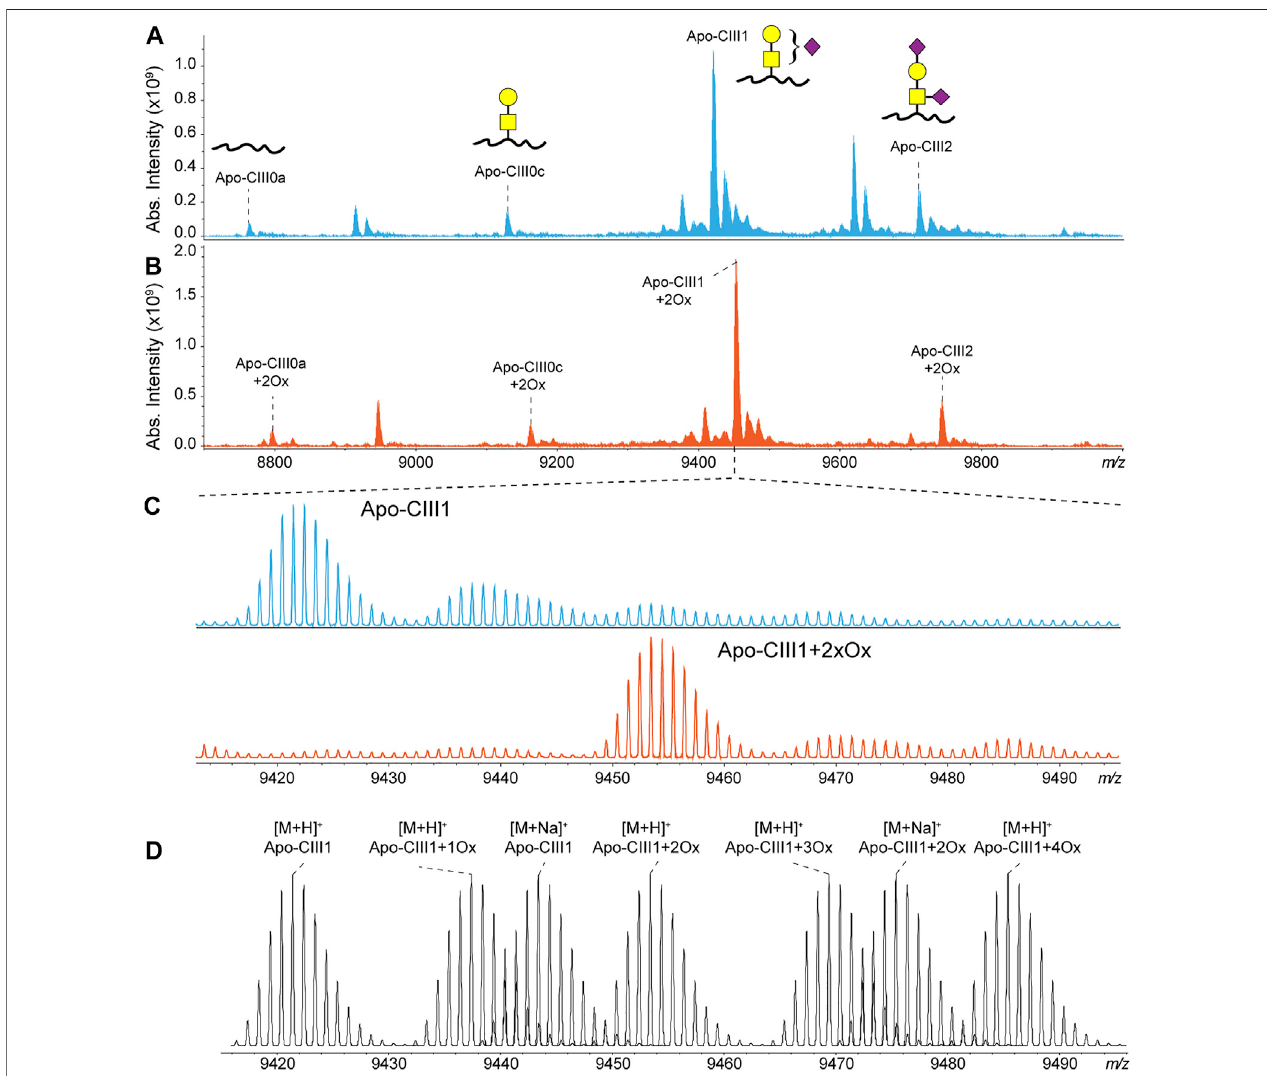
FIGURE 1 | MALDI FT-ICR mass spectra of apo-CIII proteoforms from (A) non-treated (blue) and (B) H 2 O 2 treated (orange) human blood plasma samples. The four most abundant proteoforms of apo-CIII are annotated. Mass spectra from non-treated samples are characterized by the presence of oxidoforms as exempli fi ed for apo-CIII1 in panel (C) . The H 2 O 2 treatment allows the almost complete conversion of methionine residues to methionine sulfoxide with a minor conversion to methionine sulfone. Theoretical isotopic distribution of apo-CIII1 proteoforms are depicted in panel (D) . For graphical representations of glycan structures: yellow square (N-acetylgalactosamine), yellow circle (galactose), purple diamond (N-acetylneuraminic acid).